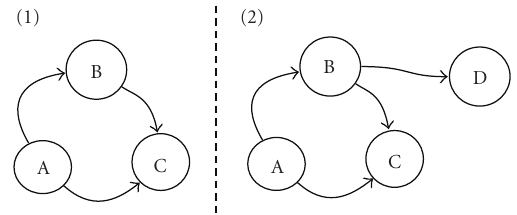
Figure 4: Extension of a state machine using the extension-by- connection